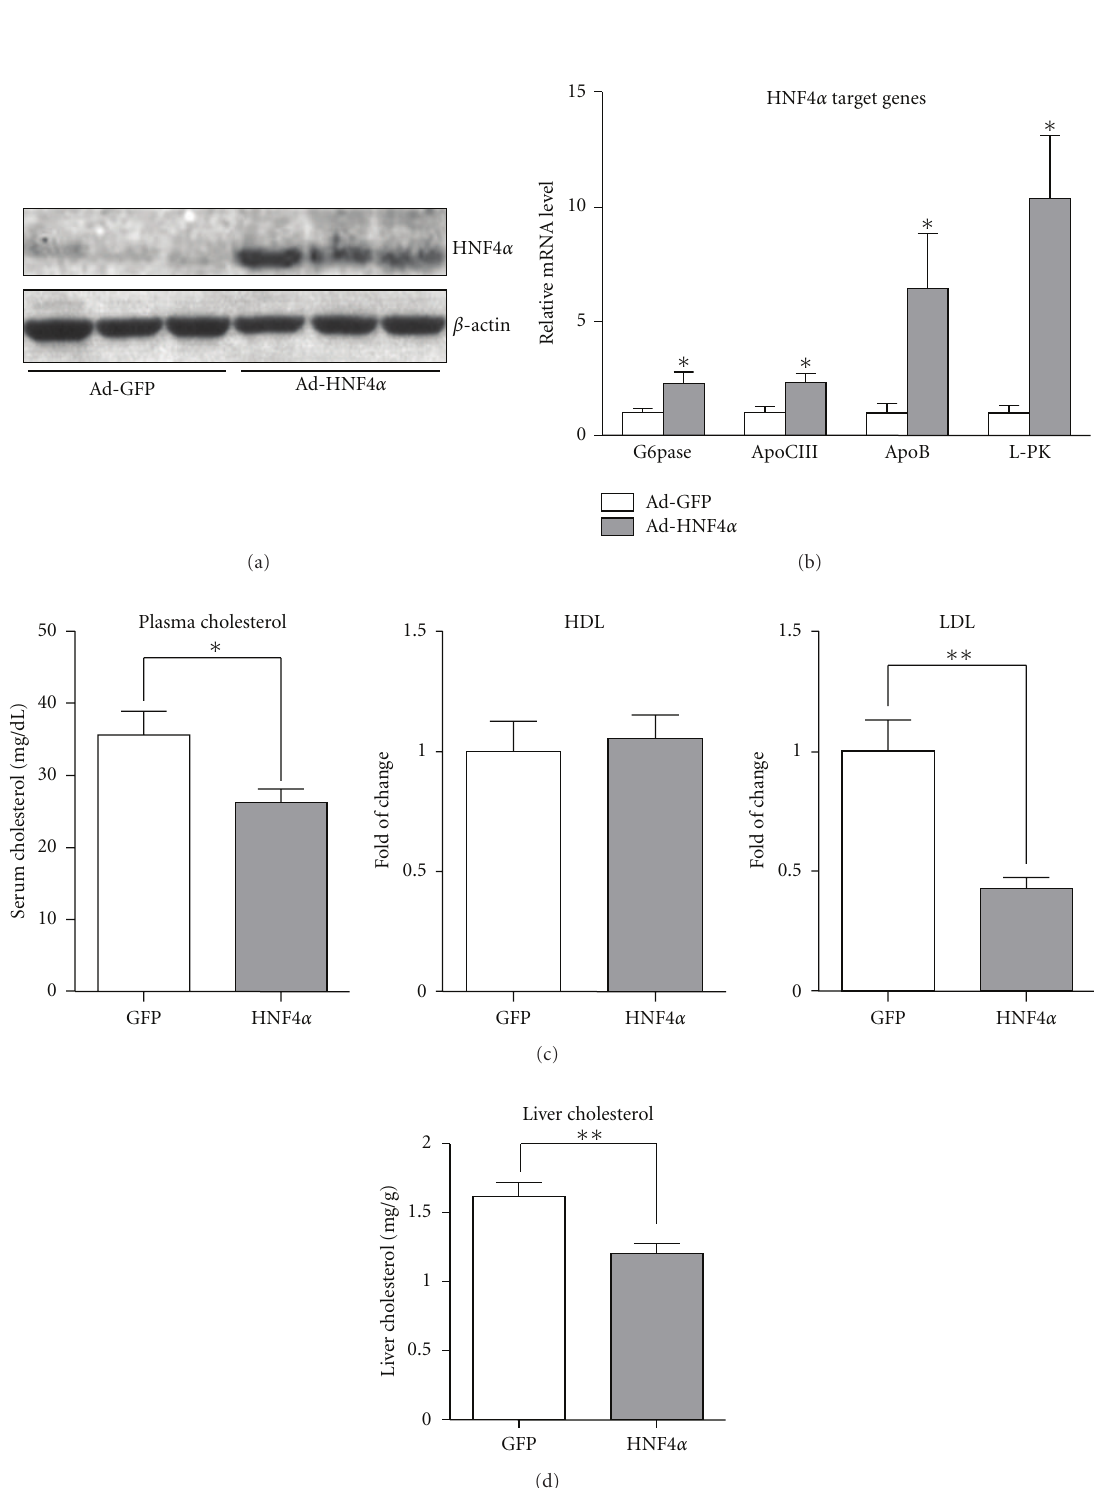
Figure 3: Hepatic overexpression of HNF4 α in rats decreased cholesterol levels in both plasma and liver. Rats were intravenously injected with Ad-HNF4 α or Ad-GFP ( n = 6), then killed 7 days post-infection. (a) Liver extracts were used to determine protein expression by western blot analysis with antibodies against HNF4 α or β -actin. (b) Relative mRNA levels of hepatic HNF4 α target genes, including G6p, Apoc3, Apob, and L-pk, were examined by qPCR. (c) Plasma cholesterol, high-density lipoprotein cholesterol (HDL-C), and low-density lipoprotein cholesterol (LDL-C) levels were determined. (d) Liver cholesterol was measured in lipid content of rat liver. Data are mean ± SEM, ∗ P < 0 . 05, ∗∗ P < 0 . 01 versus Ad-GFP